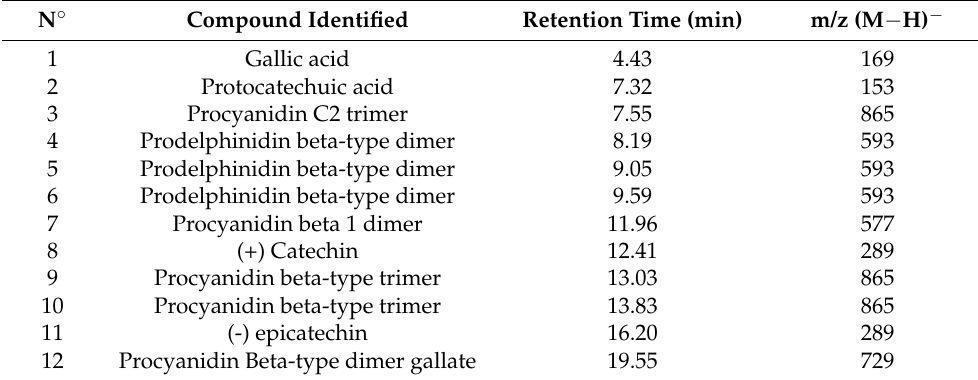
Table 2. Peaks identification of hazelnut skin methanolic extract through Figure 2. Chemical structure of some phenolic compounds identified in Hazelnut skin extract. Table 1. Peaks identification of hazelnut skin aqueous extract through HPLC/ESI-MS.